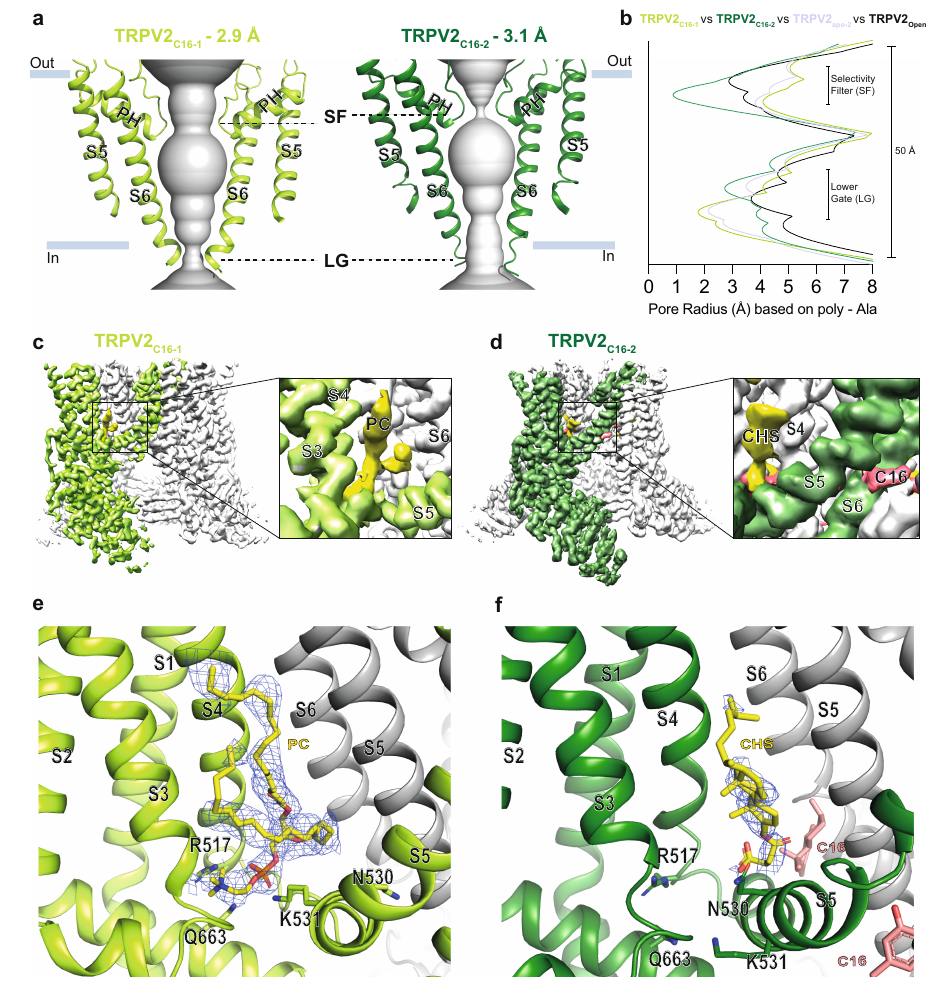
Fig. 4 | Molecular effect of C16 and the vanilloid pocket. a , b Pro fi le of the ion permeation pathway, displayed as gray space- fi lling models, for ( a ) TRPV2 C16-1 (light green) and TRPV2 C16-2 (dark green) and ( b ) the corresponding calculated radiiasafunctionofthedistancealongtheionconductionpathway.Theporeradii of TRPV2 open (PDB-ID: 6BO4) and TRPV2 apo-2 (PDB-ID: 6U86) are also included as references and shown by black and white-blue lines, respectively. All pore calcu- lations in this and subsequent analyses are based on polyalanine exchange of residues504to651includingtheporehelix(PH),selectivity fi lter,andlowergateto